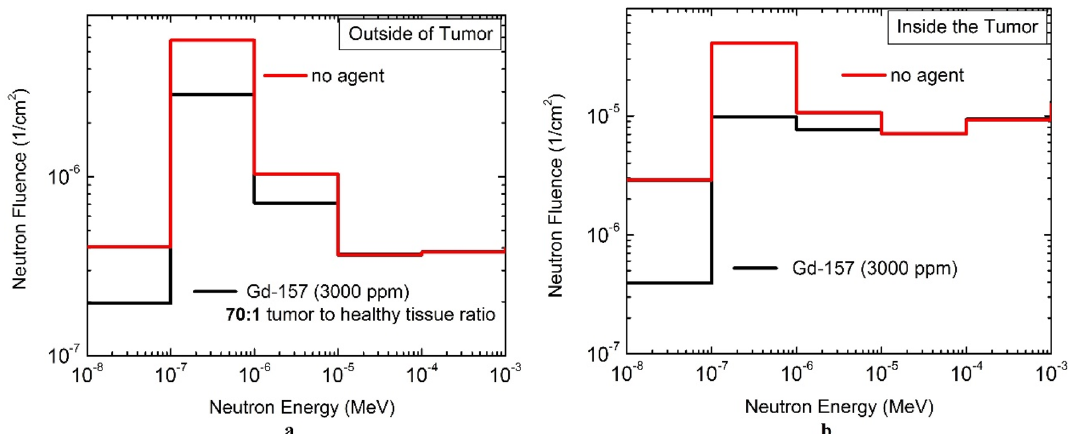
Figure 4. The variation of the secondary neutrons (from thermal up to 1 keV) in proton therapy when 3000 ppm of gadolinium-157 has been concentrated in tumor with 70:1 tumor to healthy tissue ratio. ( a ) Depicts more that 50% decrease in thermal to epithermal neutron fluences outside of tumor (in healthy tissue) and ( b ) shows more than one order of magnitude decrease in neutron inside of